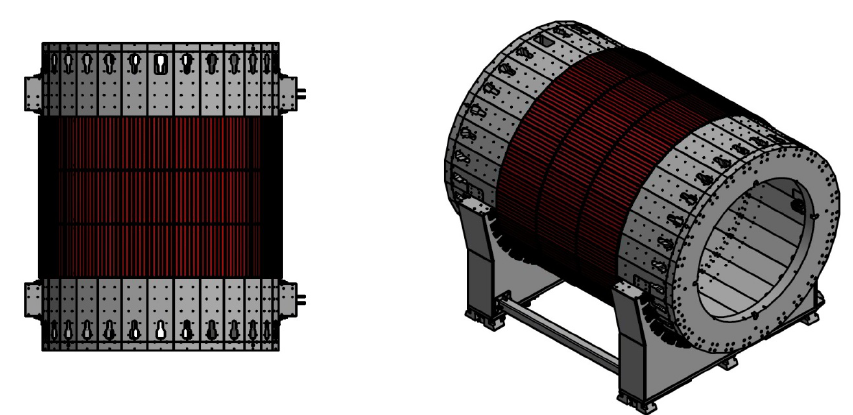
Figure 7. Basic version of the MCORD design surrounding the MPD detector at the NICA